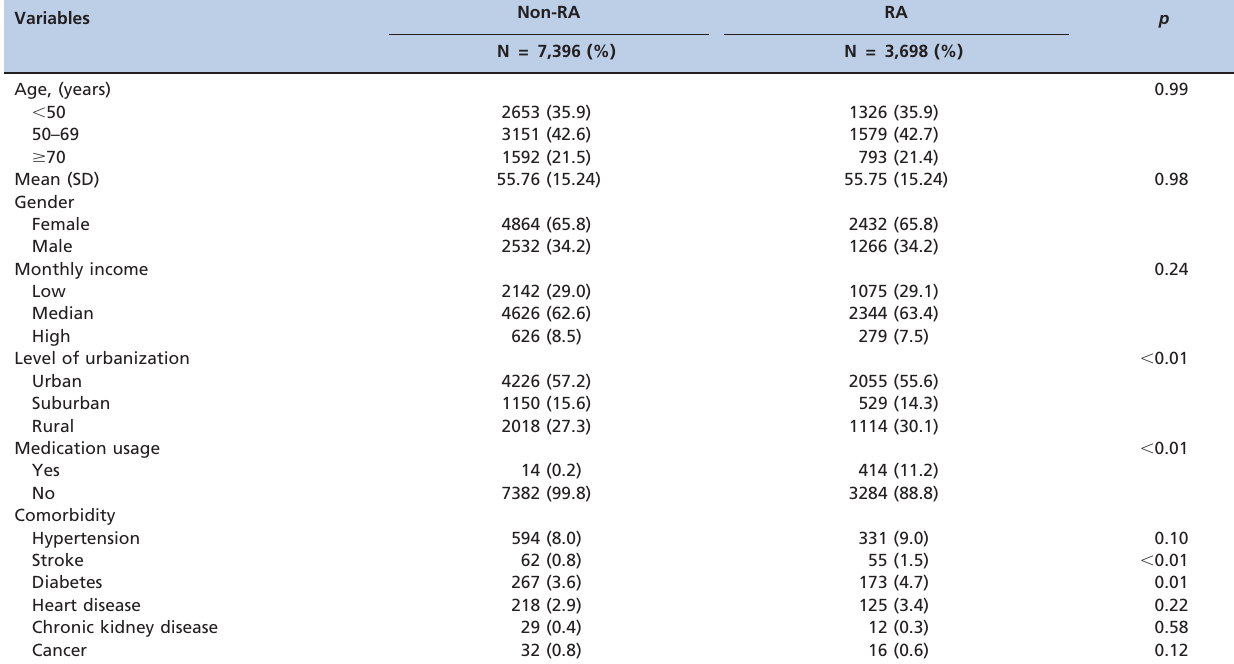
Table 1 - Demographic data and comorbidity comparison of the study subjects. Variables